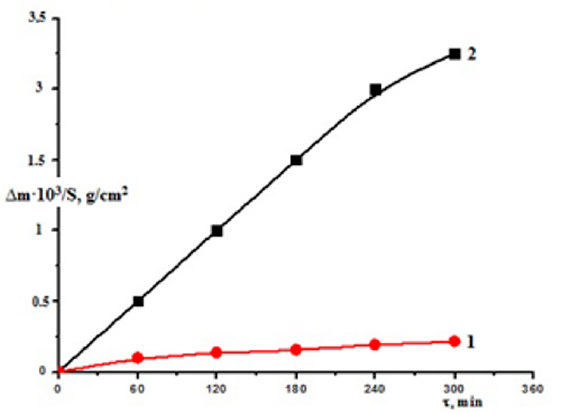
Figure 5. Kinetic curves of Zr1%Nb in ( 1 ) thermal and ( 2 ) radiation–thermal processes in seawater.